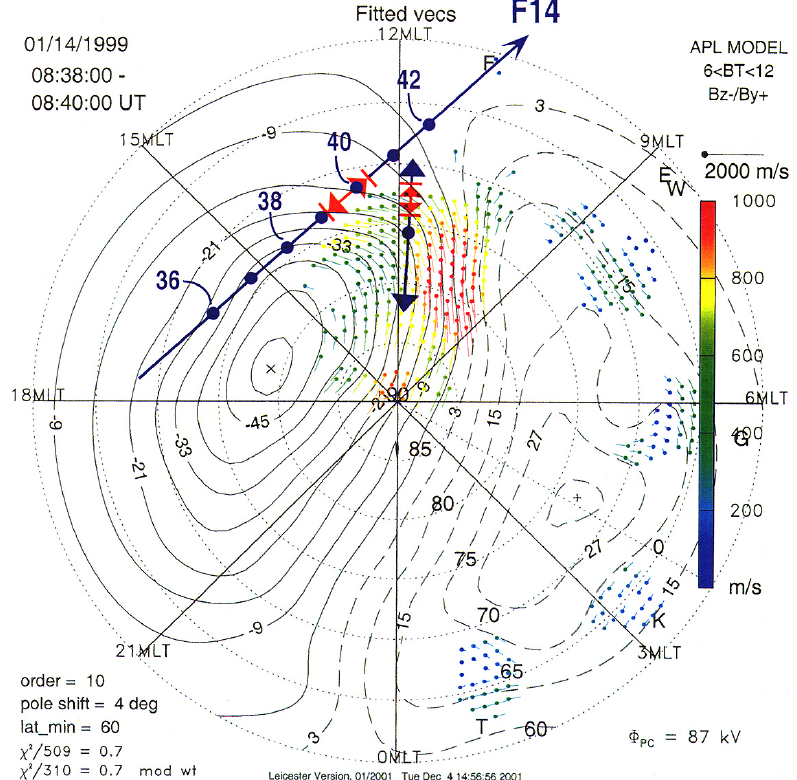
Fig. 12. SuperDARN vector plot for the interval 08:38–08:40UT. Same format as in the previous figure. The trajectory of spacecraft DMSP F14 during the interval 08:36–08:42UT is inserted, as well as the field of view of the MSP in Ny ˚Alesund (meridional double-arrowed